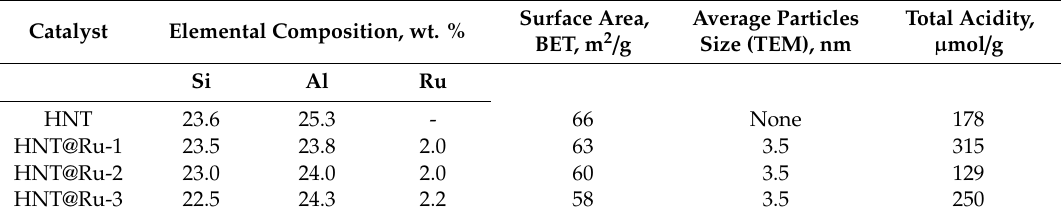
characteristics